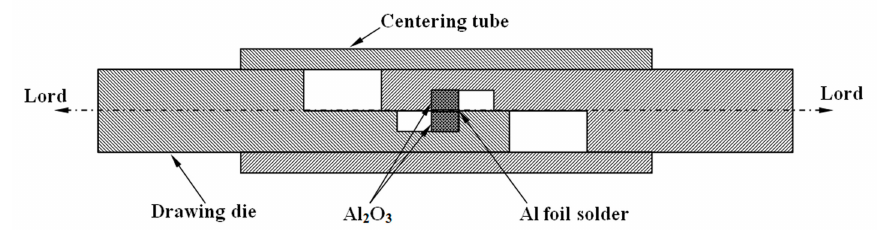
Figure 3. The fixture schematic diagram for measuring shear strength of brazed joints.